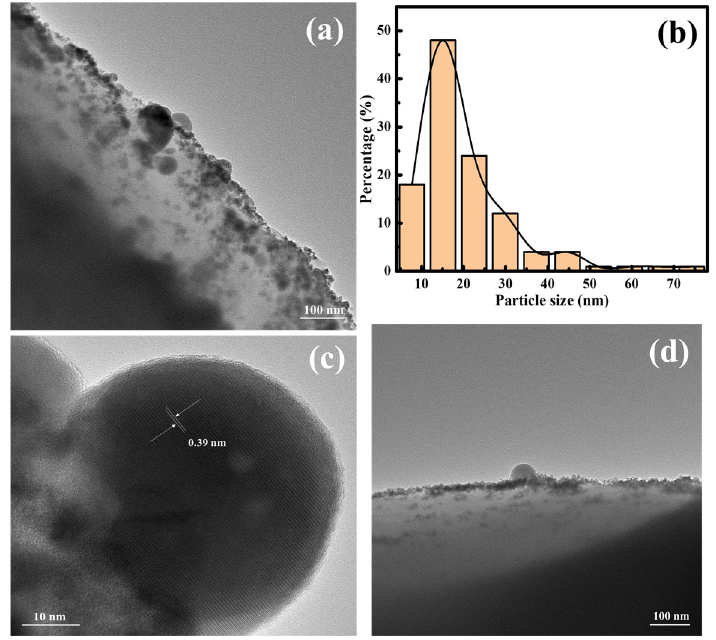
Figure 6. TEM images: ( a ) Fresh Rh/DAC-BINAP; ( b ) Particle size distribution of Rh nanoparticles ( c ) Lattice fringe of Rh nanoparticles; ( d ) the reused Rh/DAC-BINAP come from hydrogenation six times. Table 1. Solvent Screening for Rh-Catalyzed Asymmetric Hydrogenation of 2-acetamido-3-phenylprop-2-enoate [a].